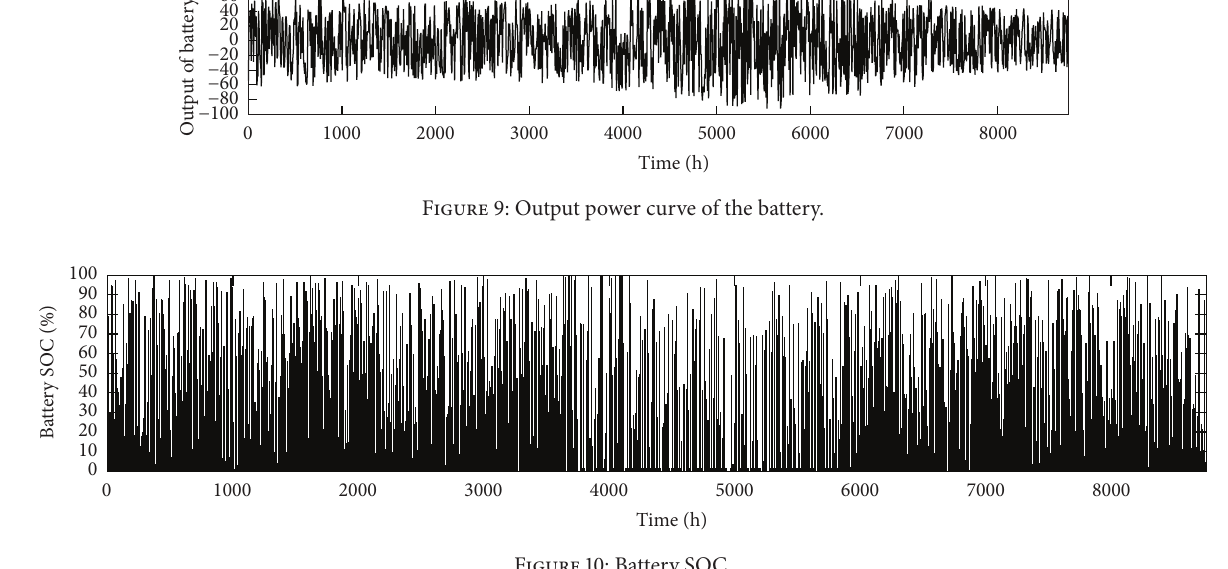
Figure 10: Battery